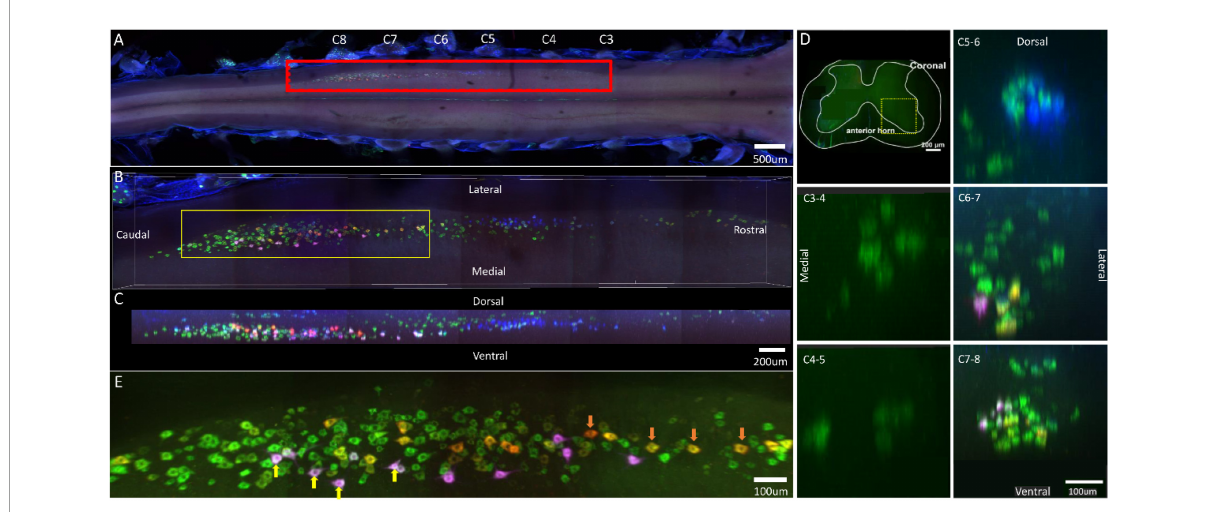
FIGURE5 Distribution characteristics of motor neurons targeting different muscles innervated by median nerves. Motor neurons innervating flexor carpi radialis (labeled by FG, blue), palmaris longus (labeled by FR, red), flexor digitorum profundus (radialis) (labeled by CTb-647, purple), flexor digitorum superficialis (labeled by CTb-488, green). (A) Spatial images of multi-tracks in a holistic view. (B,C) The relative spatial positions of the motor neuron columns targeting different muscles in sagittal and corona viewing angles. The yellow box that outlines the region of interest is shown in panel (E) . (D) The schematic diagram of the distribution of different motor neuron columns in the anterior horn of the spinal cord. The yellow box that outlines the region of interest is amplified in the subpanels in panel (D) . The cross-sectional images are maximum projections of different parts of the spinal cord. (E) Motor neurons, which innervate flexor digitorum superficialis and flexor digitorum profundus (radialis), are some double-labeled (Yellow arrow). Motor neurons, which innervate flexor digitorum superficialis and palmaris longus, are some double-labeled (Orange arrow). Yellow is the overlap between red and green colors. White is the overlap between purple and green